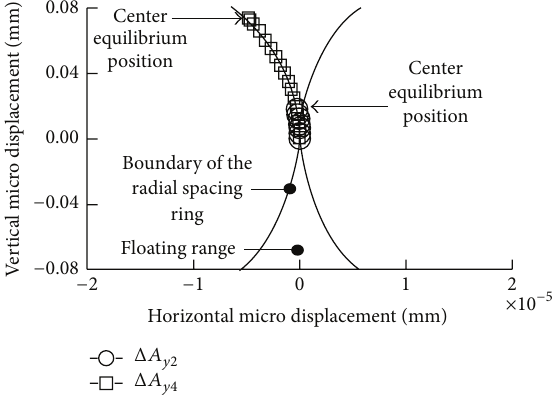
Figure 18: Floating trajectory of center equilibrium position.